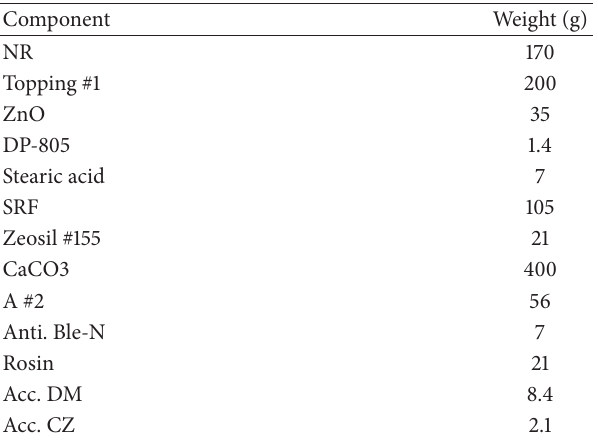
Table 1: Composition of rubber compound.